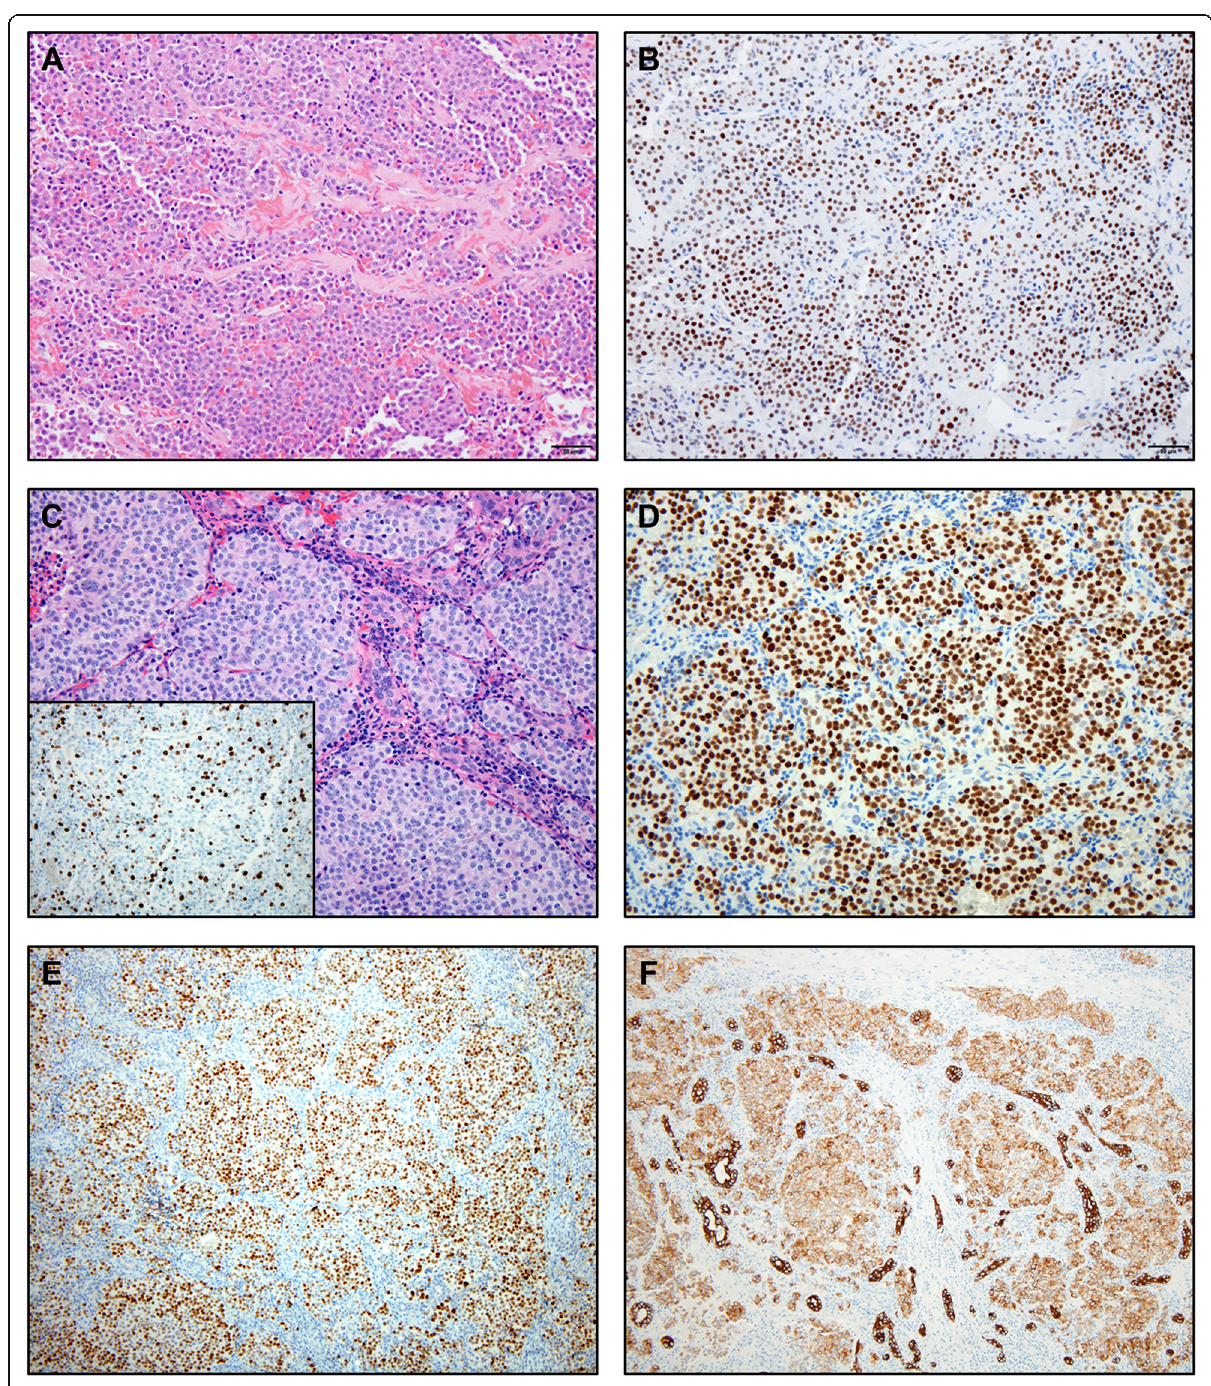
Fig. 2 a This photomicrograph of the previously resected pituitary lesion shows monotonous neoplastic cells (Original magnification × 200). b The neoplastic cells show diffuse expression of the nuclear neuroendocrine marker insulinoma associated protein (INSM1) (Original magnification × 200). c The liver shows nodules of tumor cells with moderate amounts of cytoplasm, clumped chromatin and variably prominent nucleoli (Original magnification × 200). Inset: Ki-67 shows an elevated proliferative rate of more than 10% (Original magnification × 200). d The neuroendocrine marker, INSM1 was diffusely positive in the tumor cells (original magnification × 200). e The transcription factor, T-PIT is diffusely positive confirming pituitary origin of the tumor cells (Original magnification × 100). f OSCAR cytokeratin also highlighted the tumor cells (Original magnification ×